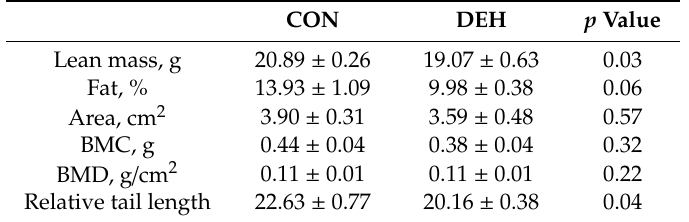
Table 1. Dehydration induces physical growth retardation in young